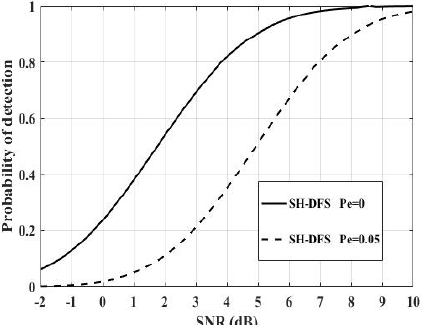
Figure 12. The probability of detection of the clustered distributed system with SH-DFS, where P e = 0 and P e = 0.05.